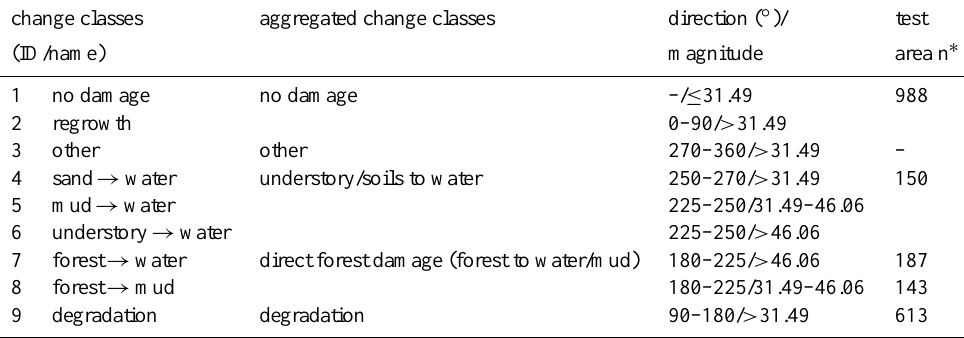
Table 4. Change class definition based on